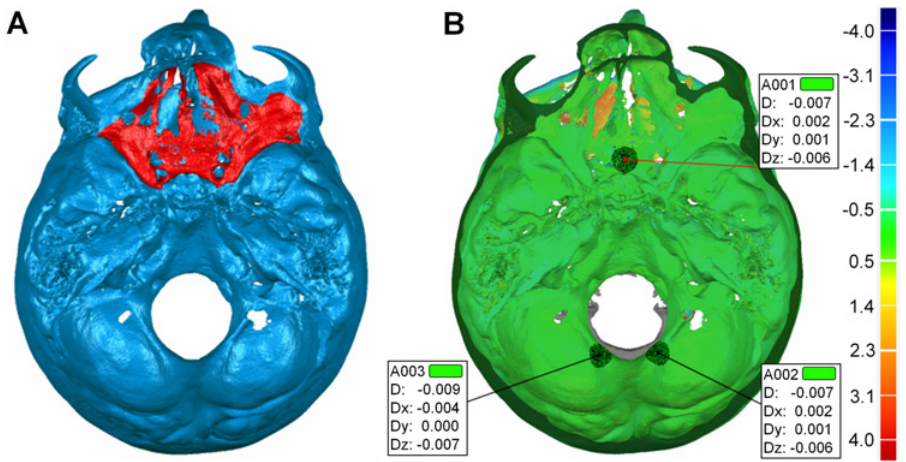
Fig 4. Test of the accuracy of each superimposition technique. After superimposition of two models (T0 and T1) in a certain area, such as (A) the anterior cranial base, accuracy was verified by measuring the distance between the two models overall (D) and in all three planes of space (Dx, Dy, Dz) on (B) three 5 mm 2 circular areas: 1. anterior surface of the sella turcica and Walker ’ s point, 2. posterior right side of the foramen magnum, and 3. posterior left side of the foramen magnum. These structures are considered form-stable in our sample and thus complete congruence of the two models (T0 and T1) is expected at the specific sites in case of successful